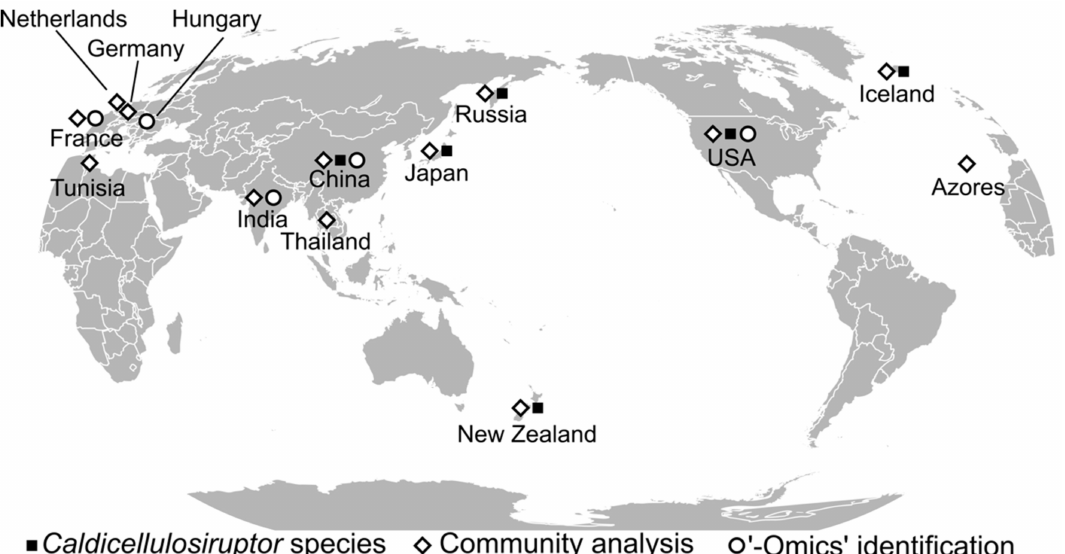
Figure 1. Global sites where members of the genus Caldicellulosiruptor have been isolated or detected. Locations are approximate to country or territory from peer-reviewed literature (see Table 2). Open diamonds, 16S rRNA gene sequencing; open circles, meta-omics identification; closed squares, Caldicellulosiruptor spp. genomic